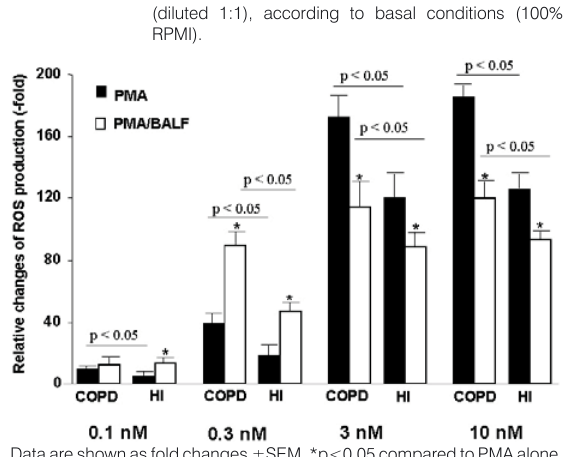
Figure 4. A graph representing modulatory effect of BALF and IS on ROS production in peripheral blood neutrophils of COPD patients and HI, after stimulation with BALF/ RPMI (diluted 1:1) and IS/RPMI (diluted 1:1), according to basal conditions (100% RPMI). Data are shown as percentage ±SEM.